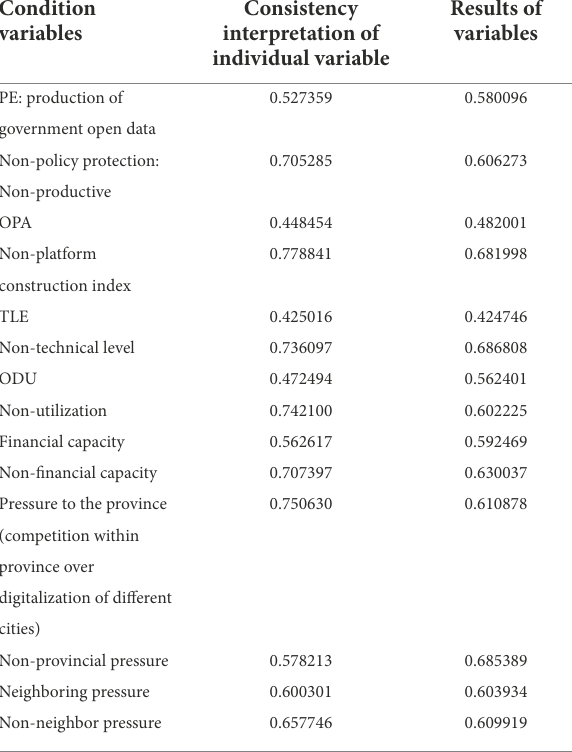
TABLE 5 Necessary conditions analysis